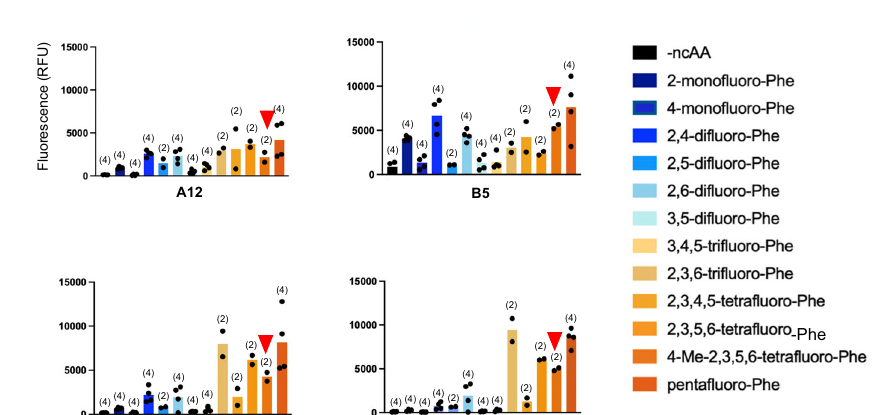
indicating the mean value. Red arrowheads indicate the level of GFP fl uorescence for para-methyl, tetra fl uoro-Phe, which was the Phe analog originally used for screening.